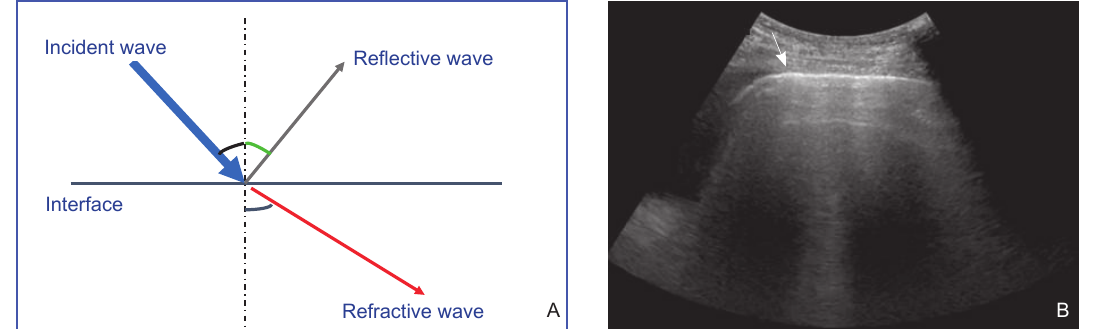
Figure 1 Acoustic impedance difference. (A) Schematic diagram of echo reflection that occurs when the interface is larger than the wavelength; (B) Pleural lines appear as strong echoes in grey-scale ultrasound image (white arrow).